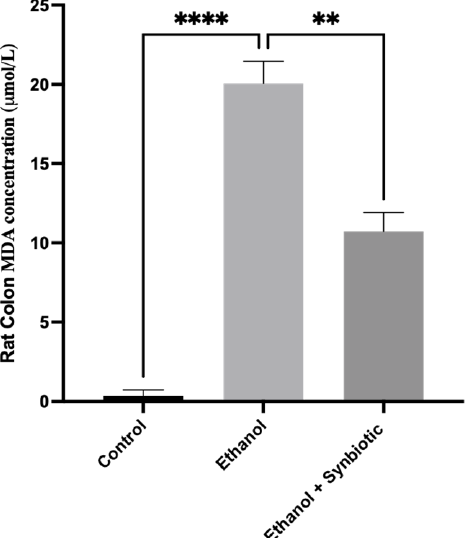
Figure 11. HPLC analysis of MDA concentration of rat colon tissue in synbiotic (AGE + L. rhamnosus ) preventive treatment has a protective effect on rat colon tissue by lowering MDA concentration even in ethanol. The statistical analysis was calculated as mentioned in Section 2.10. Mean − /+ SD was determined for N = 6 replicates. For statistical analysis, GraphPad Prism 7 and one-way ANOVA in conjunction with the Tukey post hoc test were calculated. When associated with the ethanol group, significance ( p -value) is defined as ** p < 0.01, **** p < 0.0001.